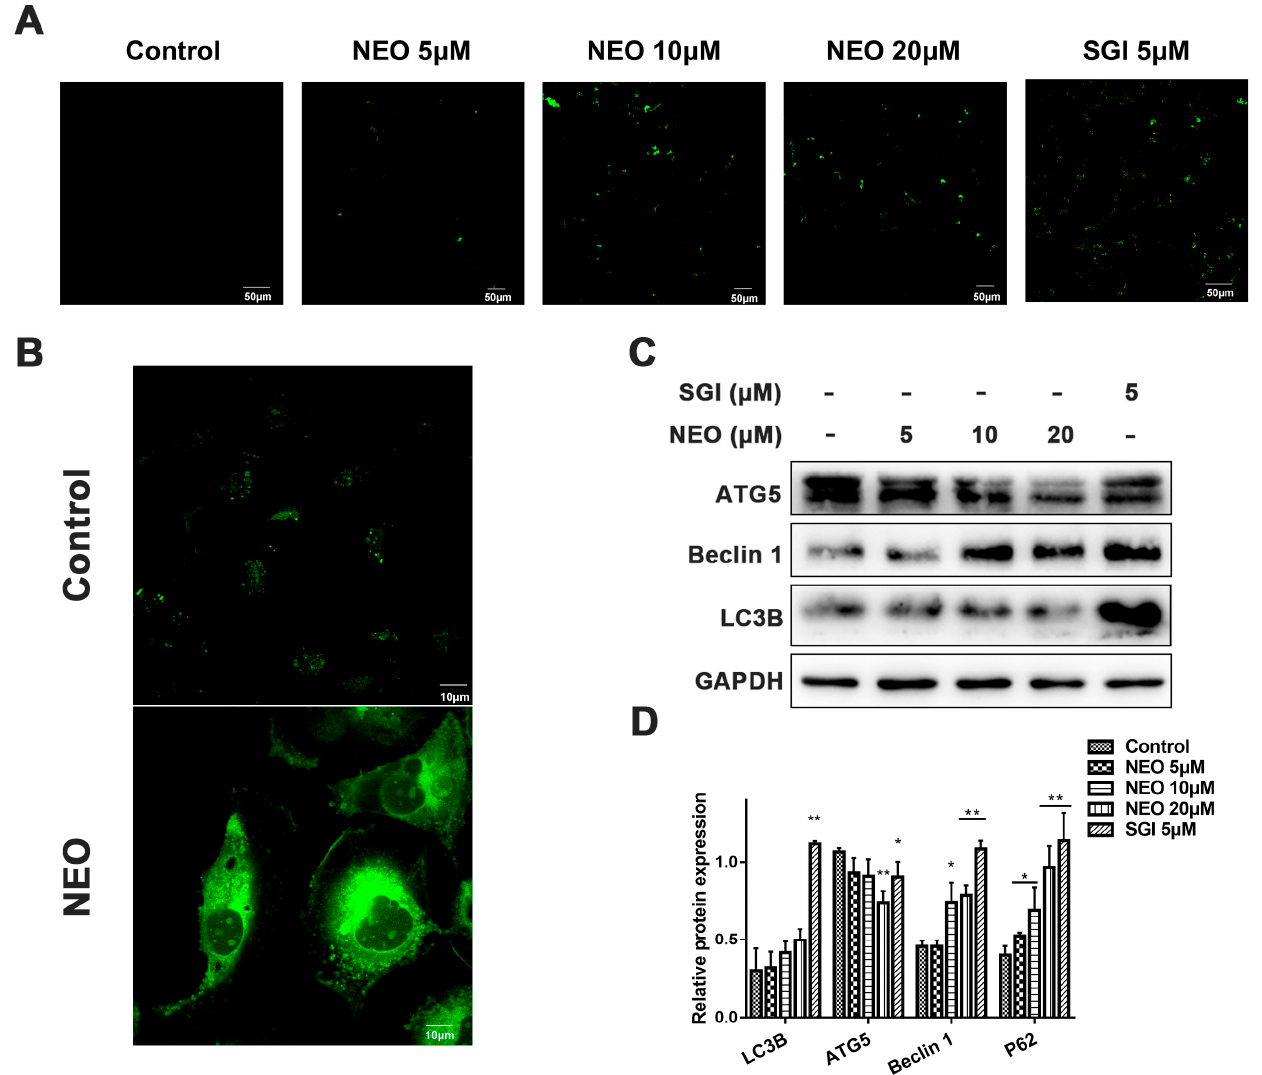
Figure 6. NEO and ibrutinib-induced autophagy. ( A ) Confocal laser-stained image of MDC, showing that MDA-MB-231 cells underwent autophagy after 24 h of exposure to NEO and SGI-1776 (there was an increase in autophagosomes (green fluorescence)) (scale bar, 50 µ m). ( B ) Partial enlarged images of the control and NEO groups stained with MDC. The NEO-induced autophagosomes can be clearly seen (scale bar, 10 µ m). ( C , D ) Western blot images. Treatment of MDA-MB-231 cells with NEO and SGI-1776 for 24 h significantly upregulated the expressions of Beclin1 and LC3B, while downregulating the expressions of ATG5. Each value is the mean ± SD for n = 3. * p < 0.05, ** p < 0.01 versus control group.